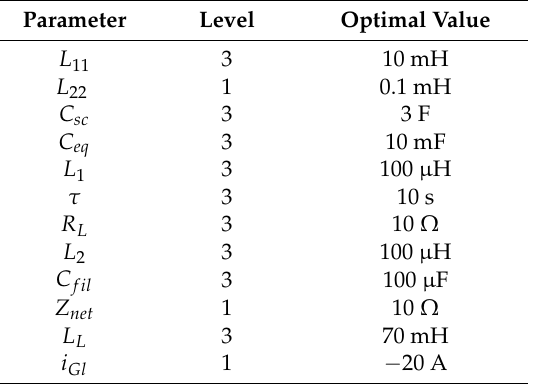
Figure 8. Mean of signal to noise ratio. Table 4. Optimal levels for micro-grid and network parameters to achieve the best stability of the